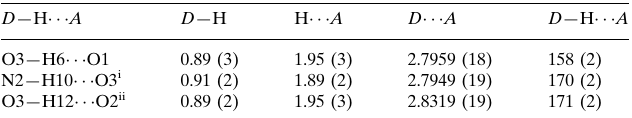
Hydrogen-bond geometry (A˚ , (cid:2)